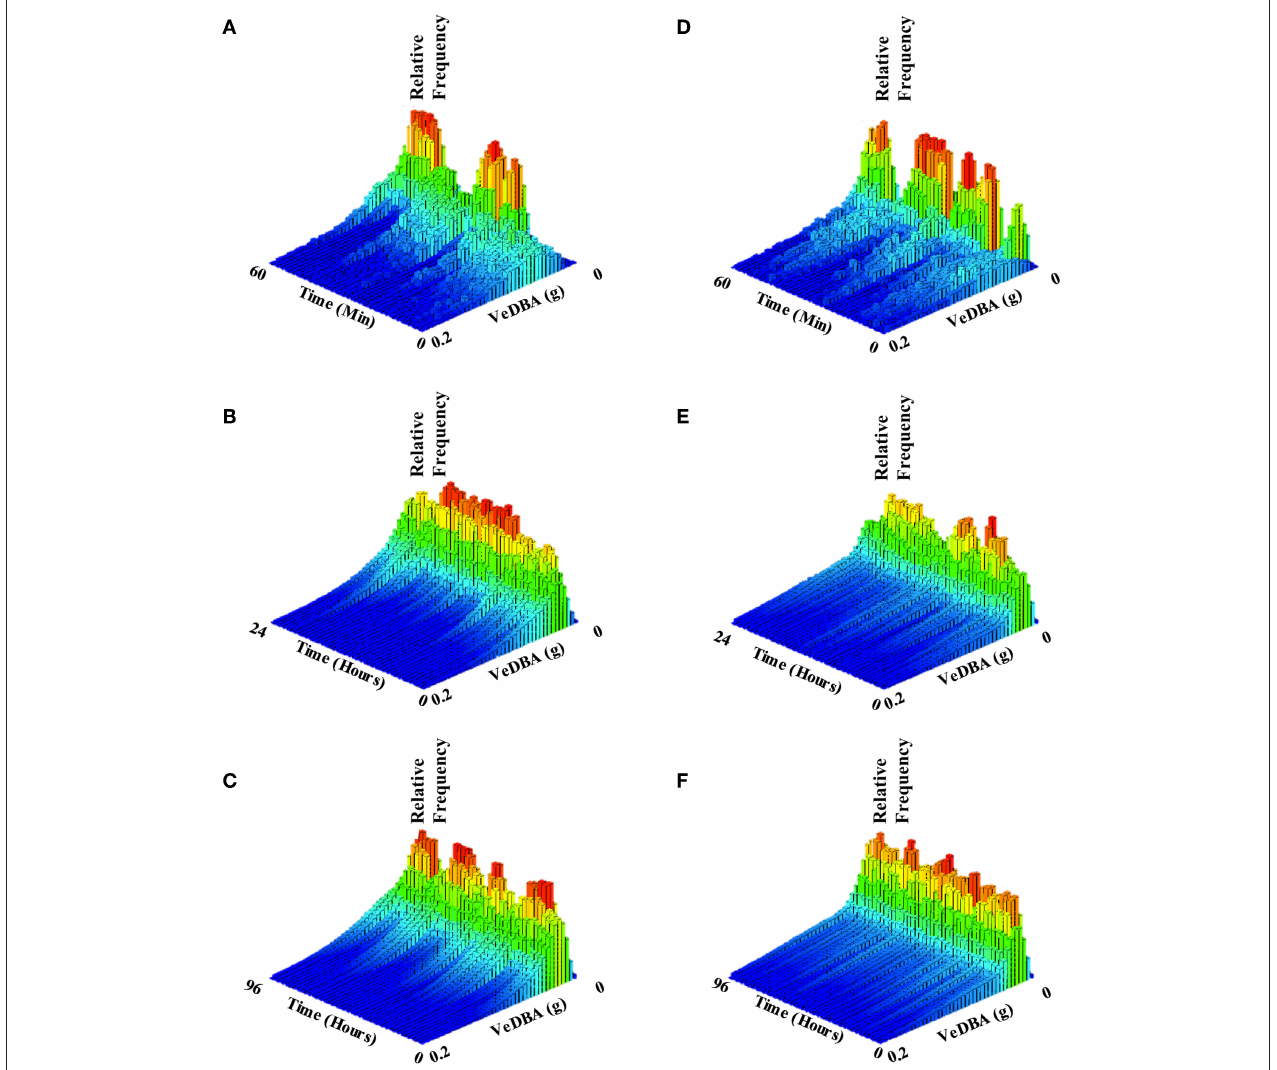
FIGURE 5 | Histograms showing allocation of activity (VeDBA) over varying time intervals, of two example turtles: T324, which was considered healthy (figures on the left; A–C ) and T331 which had intestinal gas and associated floatability issues (figures on the right; C,D,F ). Histograms cover time periods of one hour (A,D) , 24h (B,E) and four days (C,F) . Bar color and height indicate the relative number of observations within the time interval. Note how, in both example turtles, lower VeDBA values occurred most frequently (red bars) but that the individual with intestinal gas exhibited erratic periods of high VeDBA, showing high effort in bursts interspaced by a high frequency of rests (cf. A,D ) compared to the healthy individual. As the time period over which the animals are examined increases, the healthy individual spends more time overall exhibiting greater activity (manifest by the higher VeDBA - nominally from swimming) than the unhealthy animal (cf. B,C with E,F